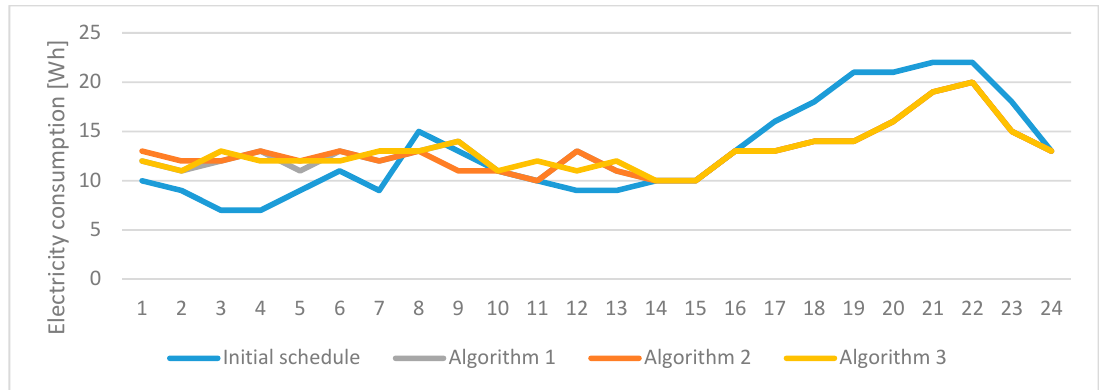
Figure 9. Initial and optimized daily consumption considering the three algorithms.